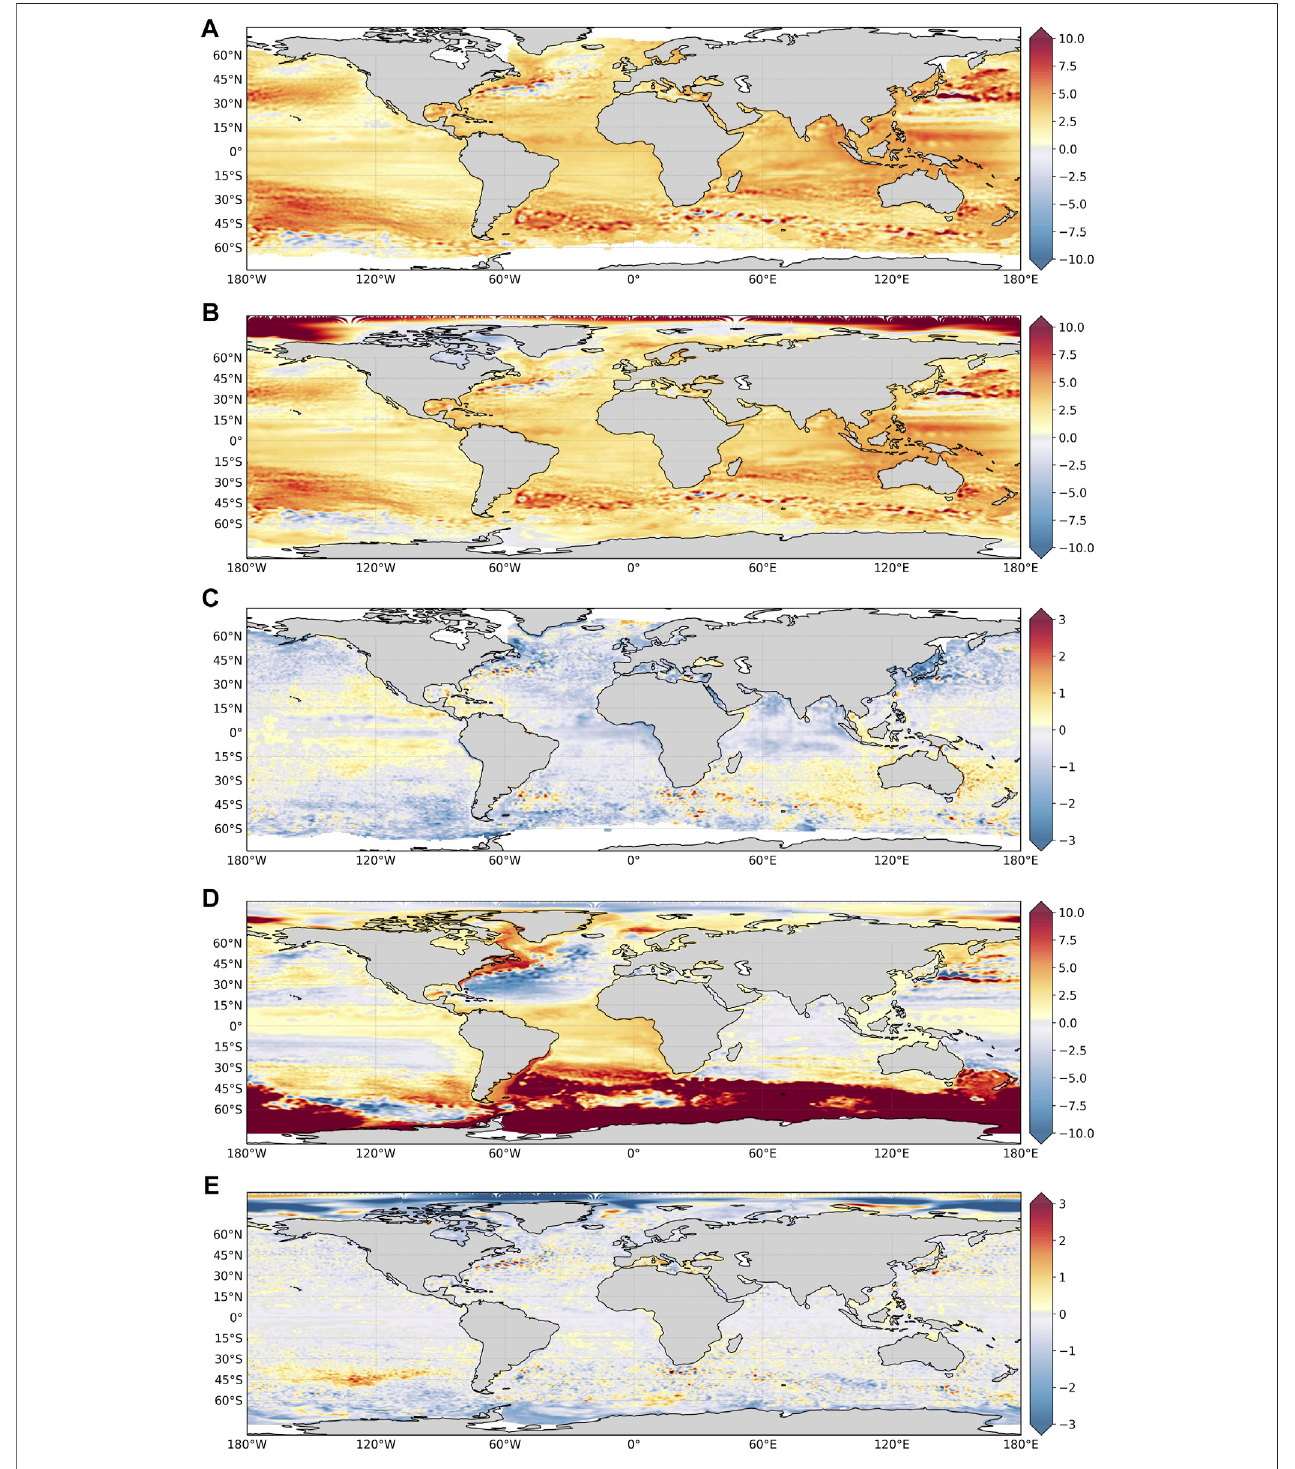
FIGURE 15 | Regional sea level trends over the 1993 – 2016 period (in mm/yr) for (A) the CMEMS gridded reprocessed altimetric dataset (007_048), (B) GLORYS12, (C) GLORYS12minusaltimetricdataset, (D) GLORYS12minusF12, (E) GLORYS12minusG4.Theglobalmeansealeveltrendhasnotbeenremoved.No GIA correction has been applied to altimetric trends in panel (A) . Note the different ranges covered by the color bars in panels ( C,E ).